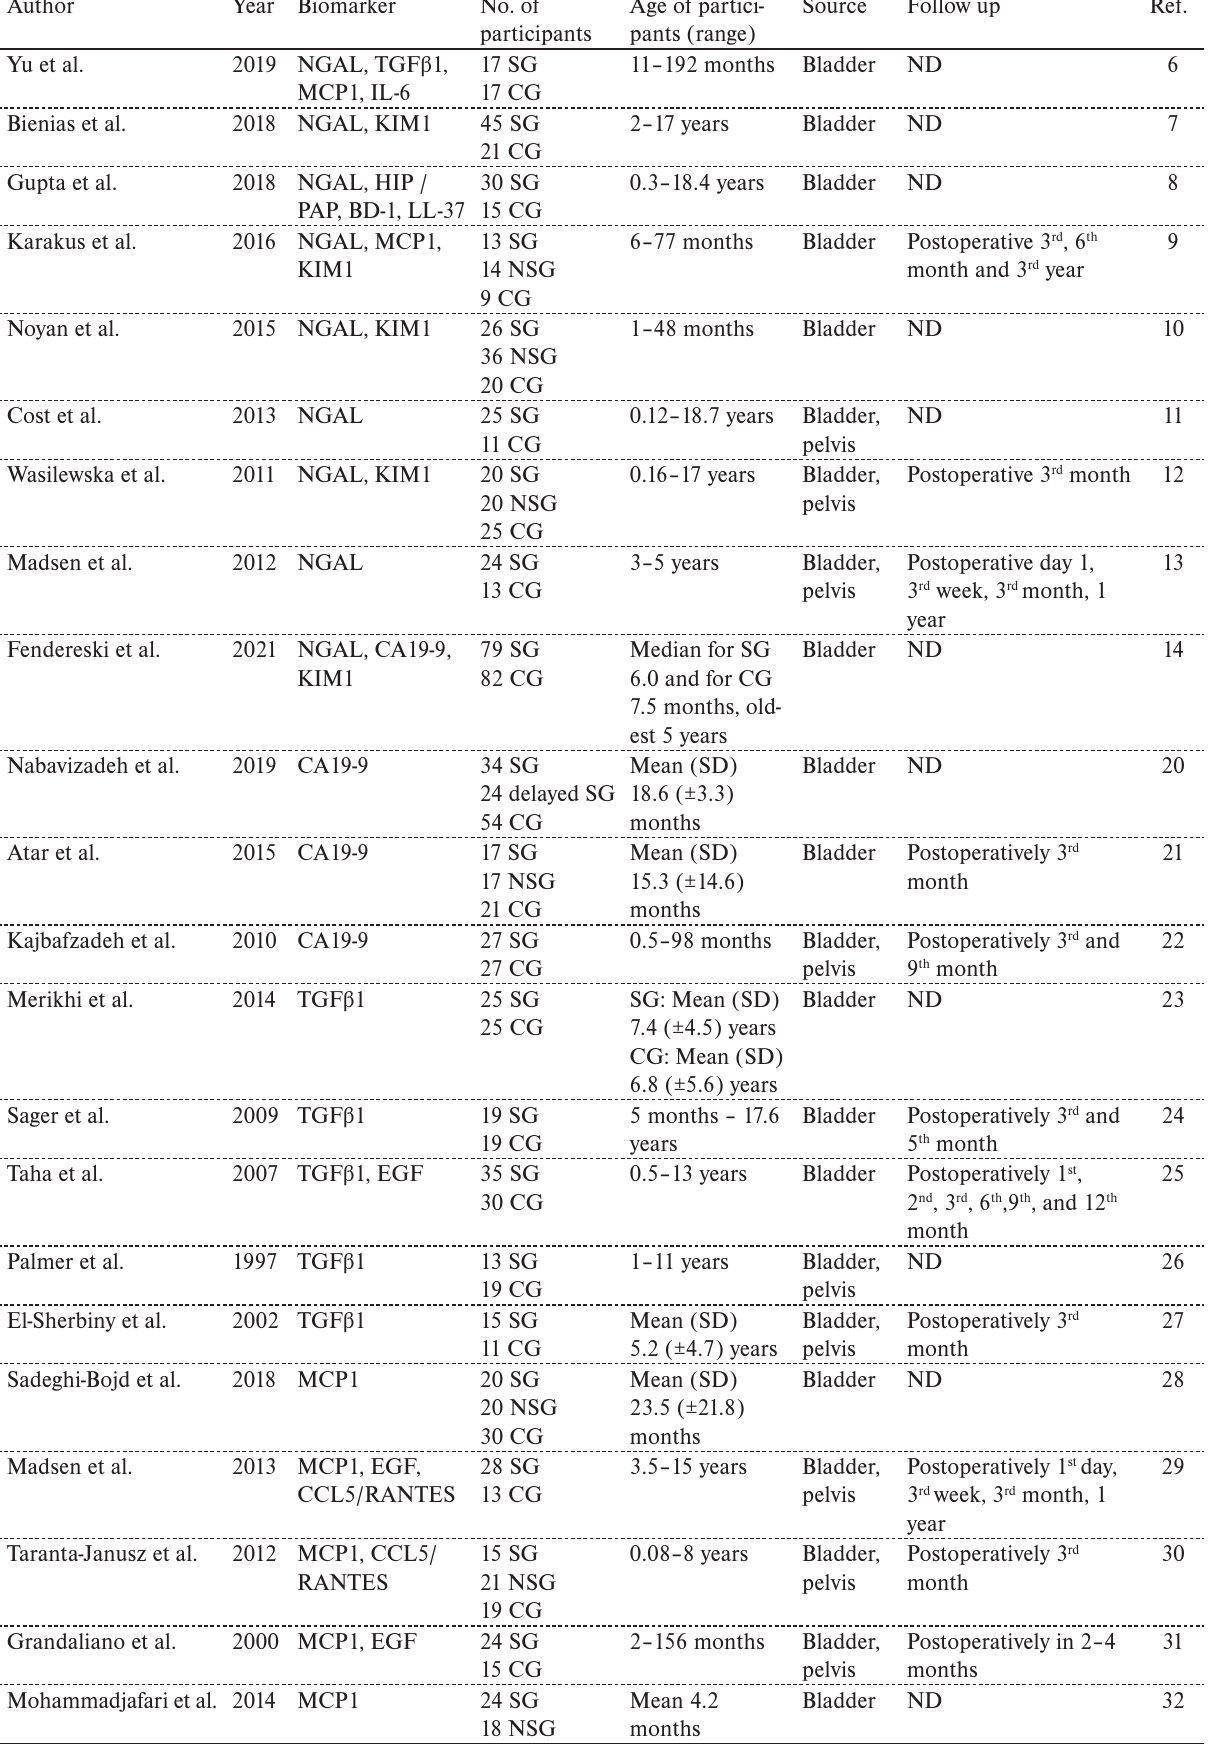
Table 2. Pediatric clinical studies on urinary biomarkers in UPJ